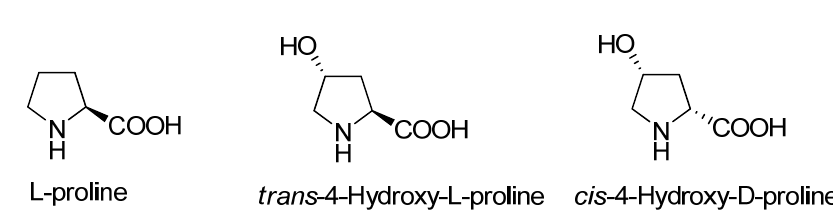
Figure 1. L -proline and two